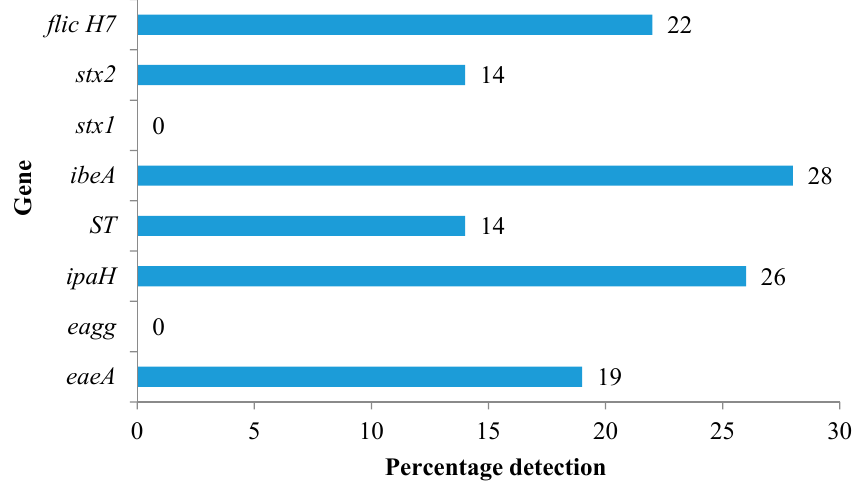
Figure 1. Overall prevalence of virulence genes in isolated E. coli from harvested rainwater (HRW) tanks.